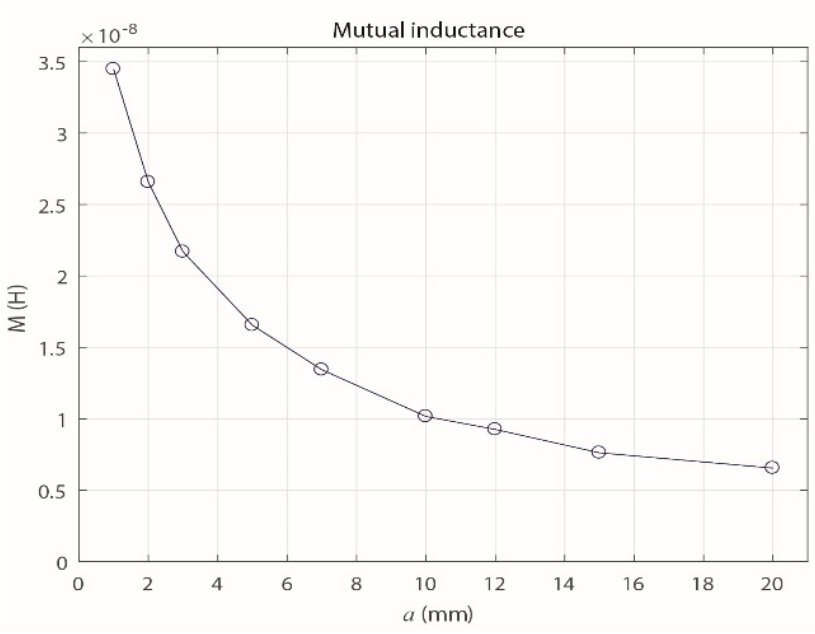
Figure 8. Experimental behavior of the mutual inductance with increasing a .